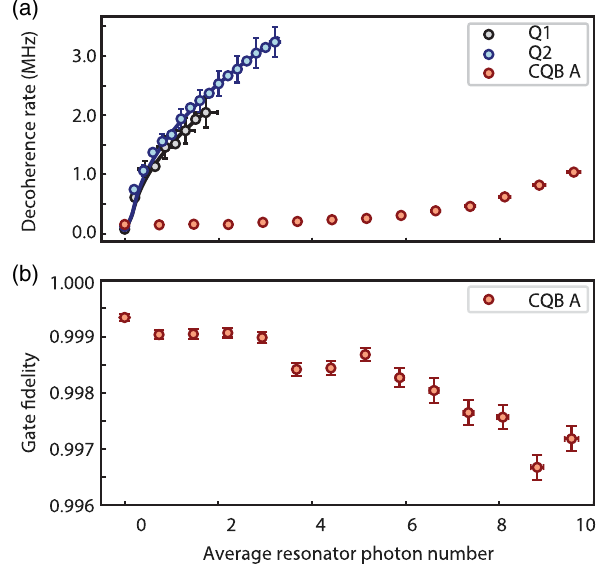
FIG. 3. Photon shot-noise characterization. (a) Ramsey decoherence rate. The CQB is protected by design against photon shot noise, exhibiting a much lower decay rate (see text). In panel (b), we show how this protection extends to operations applied to the encoded qubit, as indicated by the slow falloff of the randomized benchmarking Clifford fidelity with the number of photons in the